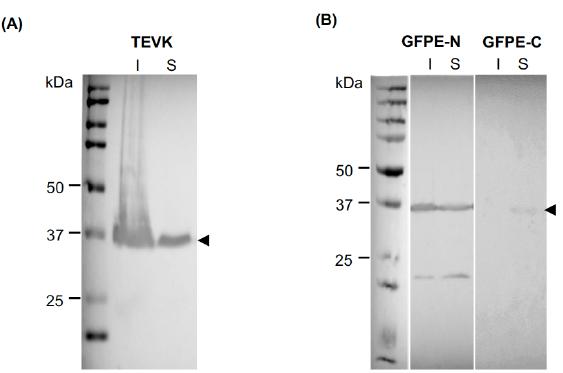
Figure 4. Western blot of ( A ) TEVK and ( B ) GFPE-N and GFPE-C proteins in bacterial lysates. I: insoluble fraction. S: soluble fraction.